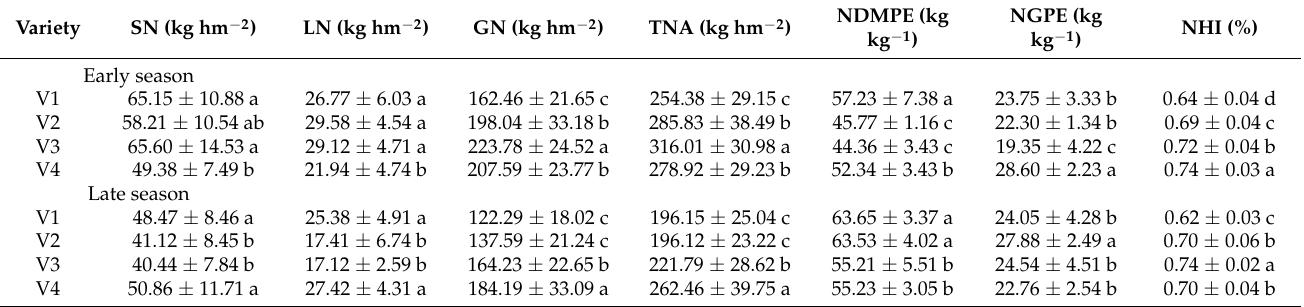
Table 9. Differences in nitrogen accumulation and nitrogen use efficiency among four rice